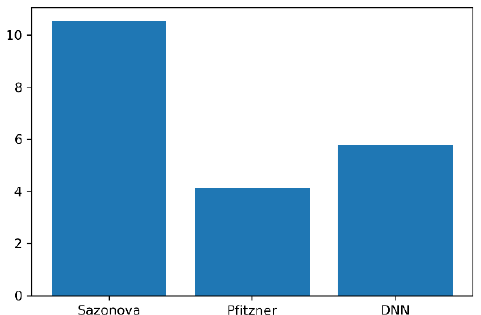
Figure 14. Comparison of performance based on RMSE between Sazonova [9], Pifizner [8], and the proposed models.